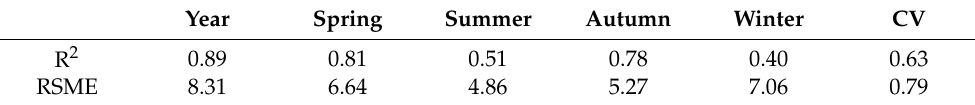
Table 4. RSME of the BP network